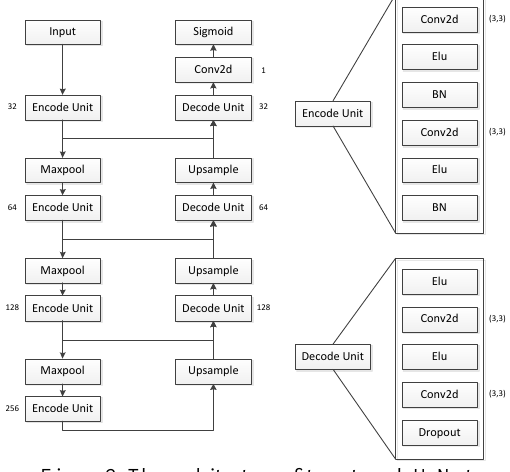
Figure 2. The architecture of target mask